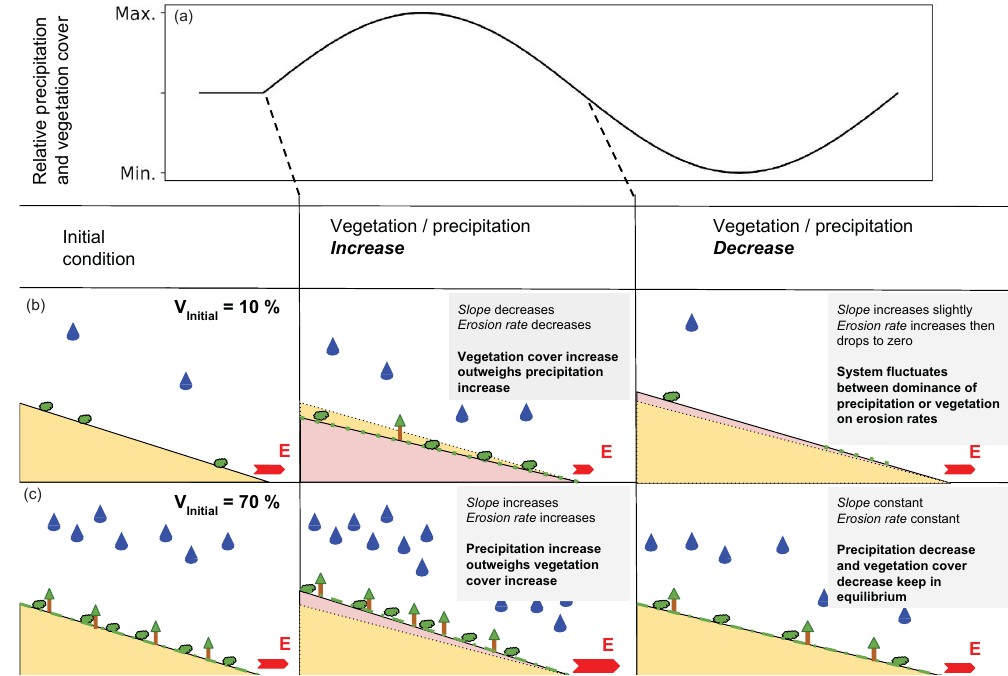
Figure 18. Conceptual figure showing the topographic response from simulations with coupled oscillation of mean annual precipitation and vegetation cover (see Fig. 17 for erosion rates). Panel (a) illustrates transient forcings, panels (b) and (c) show the initial topography (yellow) and the resulting transient topography (pink). Changes in topography are not to scale. Vegetation and rainfall amounts are shown qualitatively on the